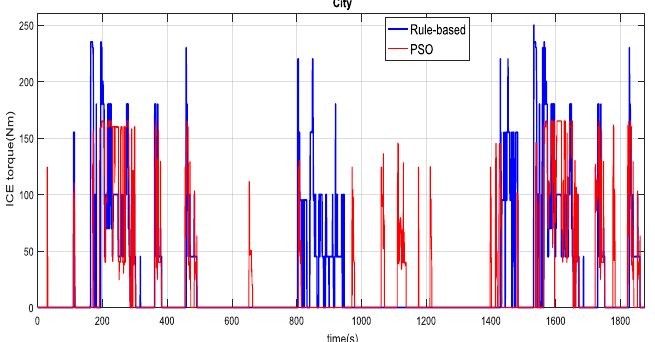
Figure 14. Comparison of engine torque in the urban driving cycle.